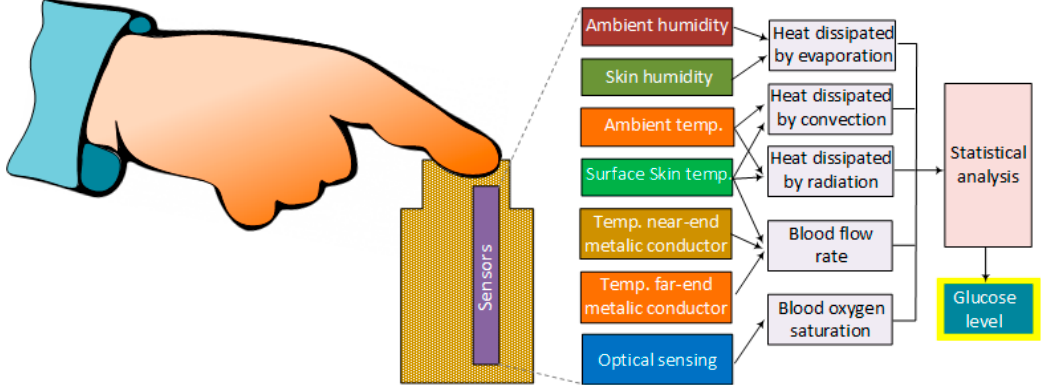
Figure 12. Glucose measurement using MHC (concept taken from [107]). Table 15. Advantages and disadvantages of MHC.